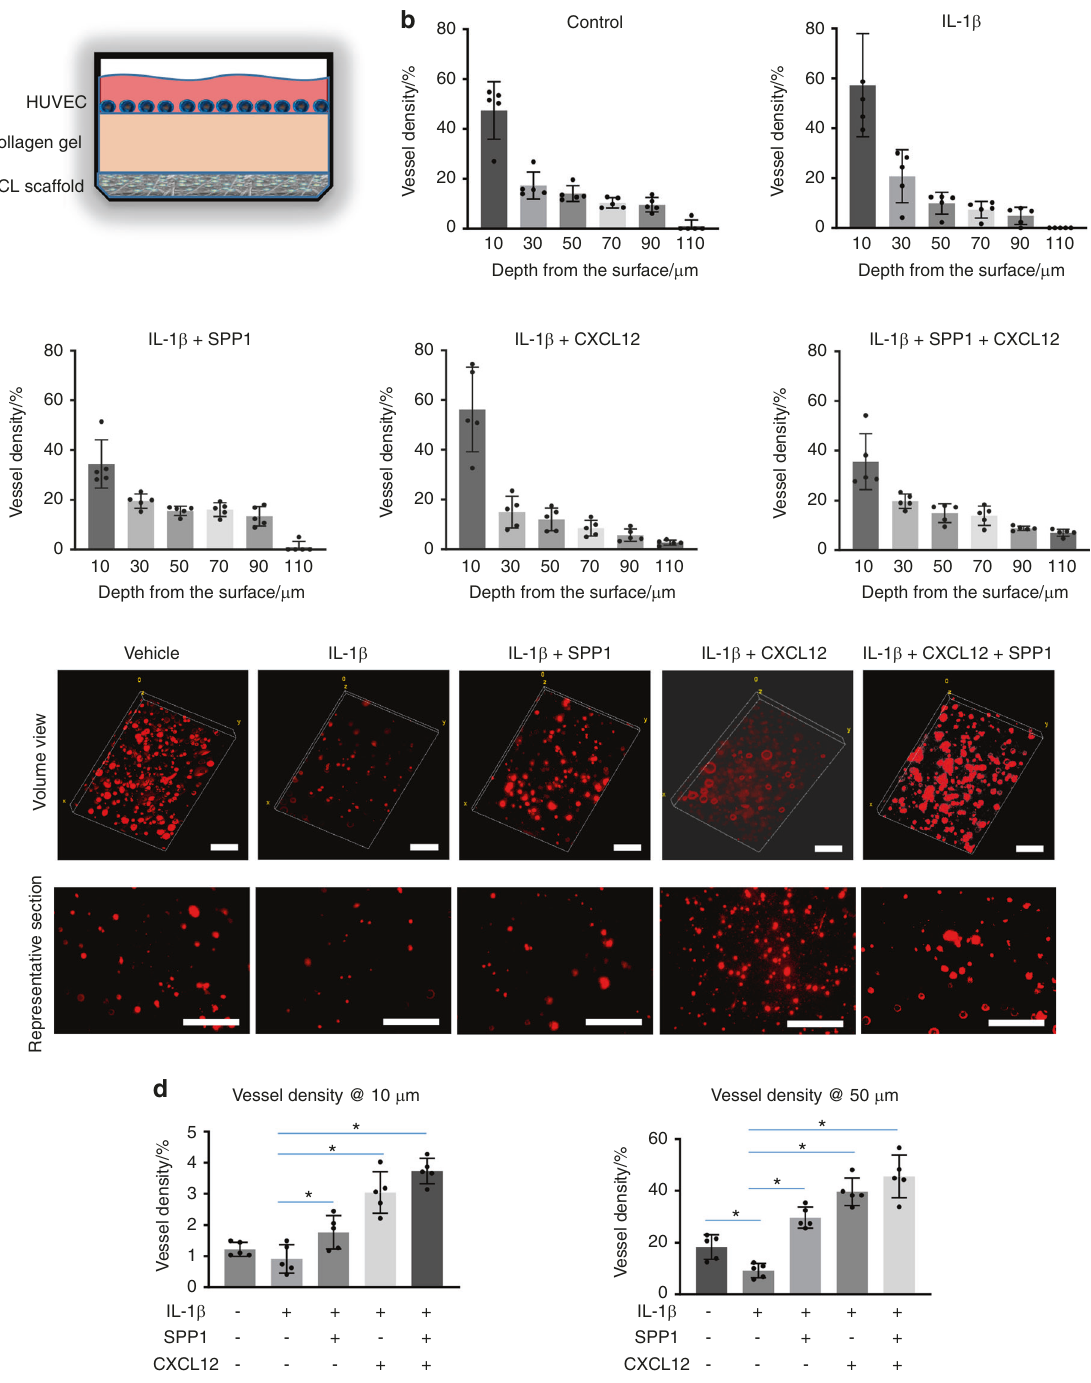
Fig. 5 The release of SPP1 and CXCL12 promoted angiogenesis under in fl ammatory conditions. a Schematic illustration of the collagen construct that was used to create the 3D cell culture environment to examine the impact of released growth factors on HUVEC migration and tube formation. b Quanti fi cation of HUVEC numbers at different depths in collagen gel ( n = 5). All results were normalized to the controls. * P < 0.05 compared with control by two-way ANOVA. c Representative images of HUVEC lumen formation in collagen gels. d Quanti fi cation of lumen density at different depths in the collagen gel ( n = 5). * P < 0.05 compared with control by two-way ANOVA. Scale bar, 200 μ